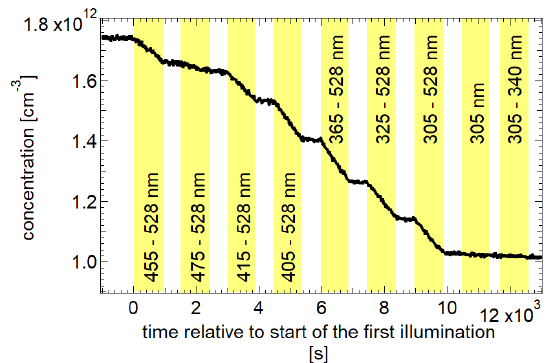
Figure 7. Concentration of 2,3-pentanedione over the course of sev- eral illumination periods with different wavelength ranges of light spectra irradiated at 298K.